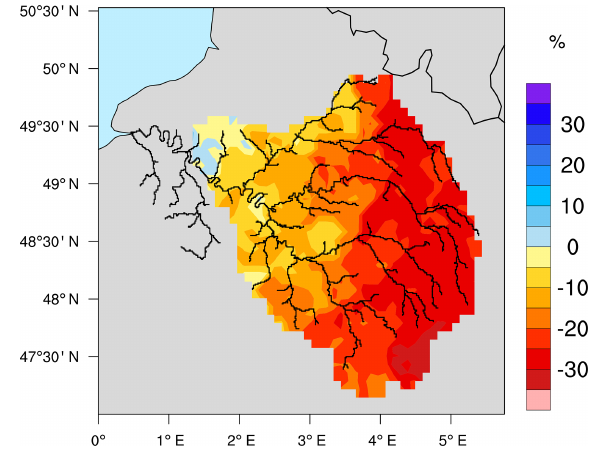
runoff and precipitation of the reconstruction, calculated in sum- mer between the negative multidecadal phases of the Seine river flows (1885–1905 and 1940–1960) and the positive phases (1910– 1930 and 1975–1995). The reference for the calculation of the rel- ative anomalies is the average of these four periods. Dots show where the differences are significant based on a Student’s t test ( p value <